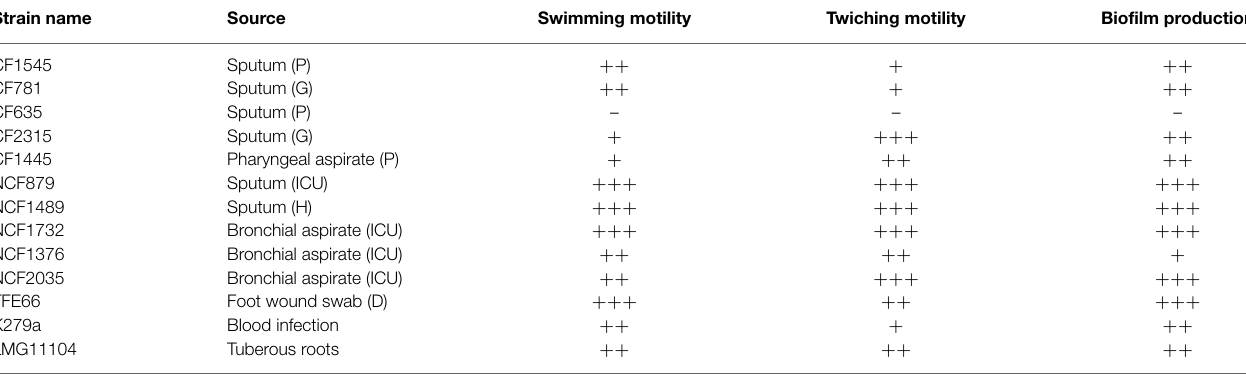
TABLE 1 | Stenotrophomonas maltophilia strains used in DC infection